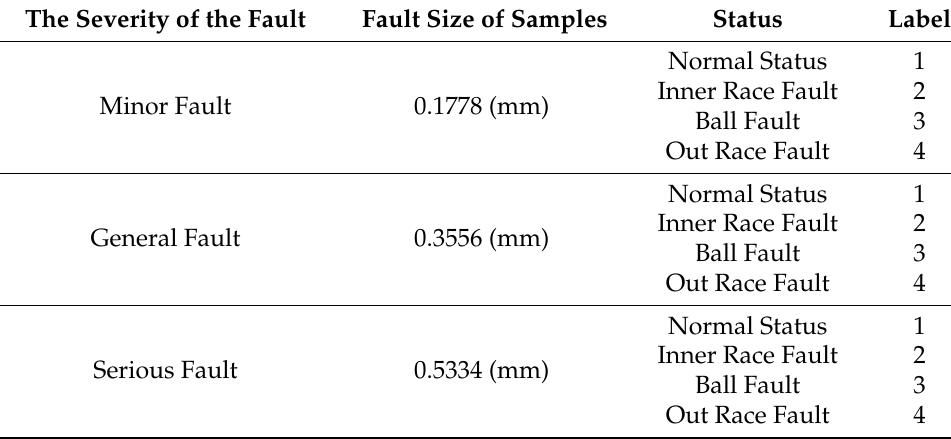
Table 5. Failure status label for each degree of fault.